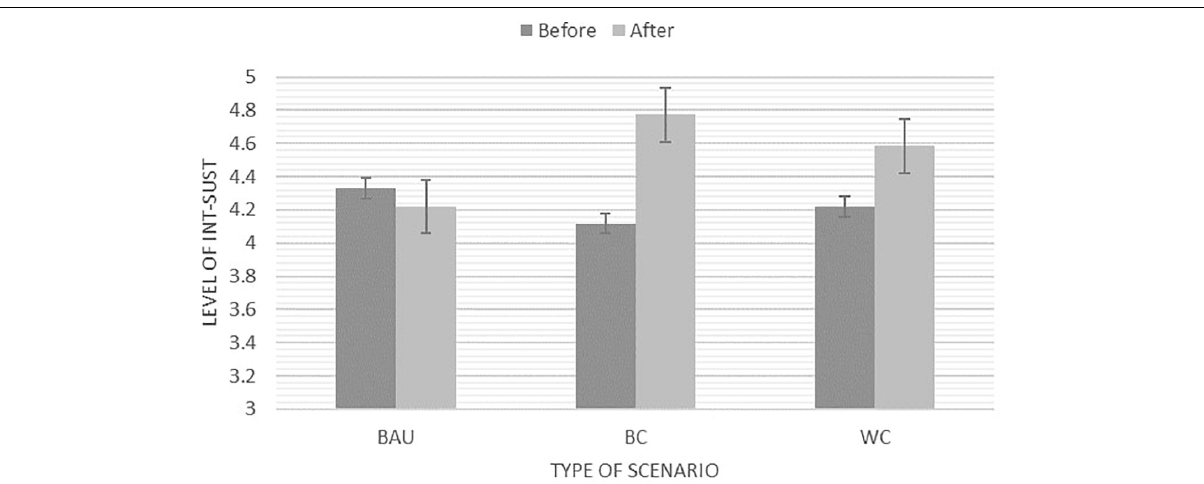
FIGURE 5 | Estimated marginal means for Int_sust before and after the creative engagement with three different types of scenarios: BAU, Business as Usual; BC, Best Case Scenario; and WC, Worst Case Scenario. NB: Y -axis adapted for illustration purposes. The Likert scale ranges from 1 ( Strongly disagree ) – 5 ( Strongly agree